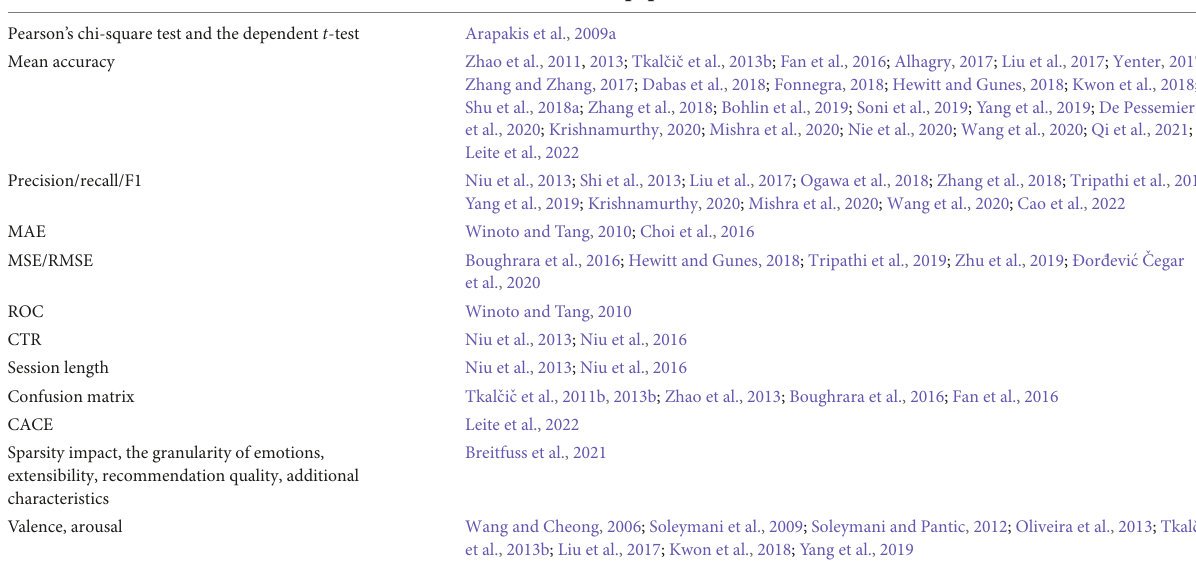
TABLE 6 The evaluation metrics of different